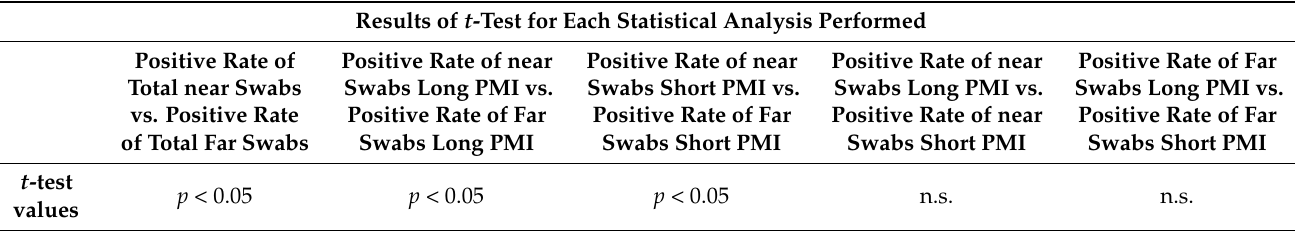
Table 4. Results of t -test for each statistical analysis performed. Results of t -Test for Each Statistical Analysis